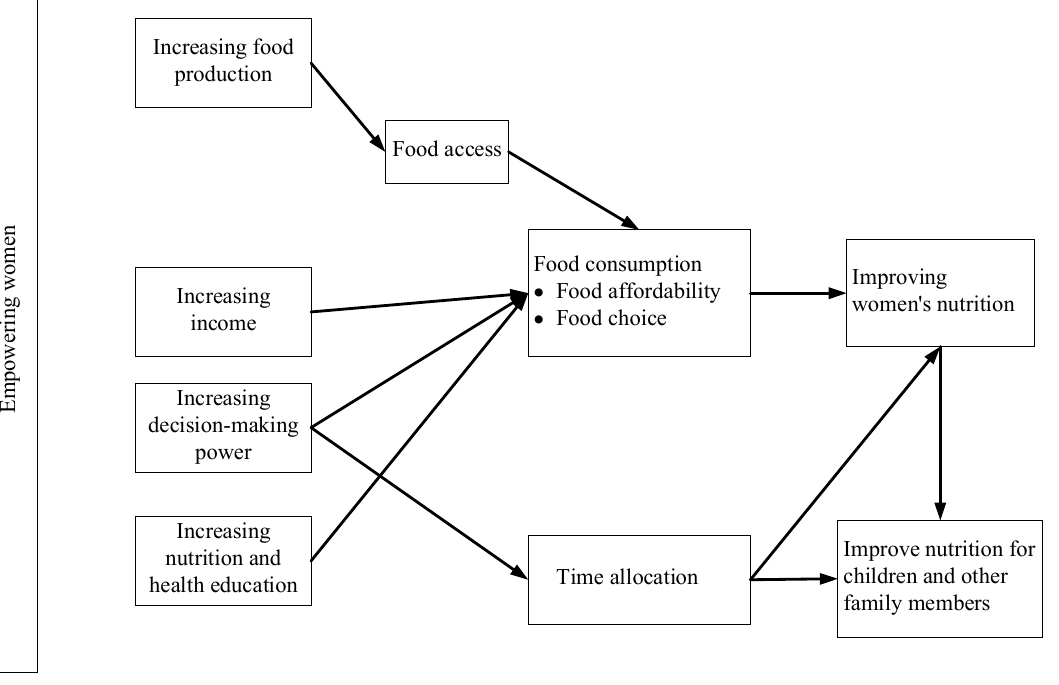
Figure 2. Empowering women to improve nutrition (author’s compilation based on